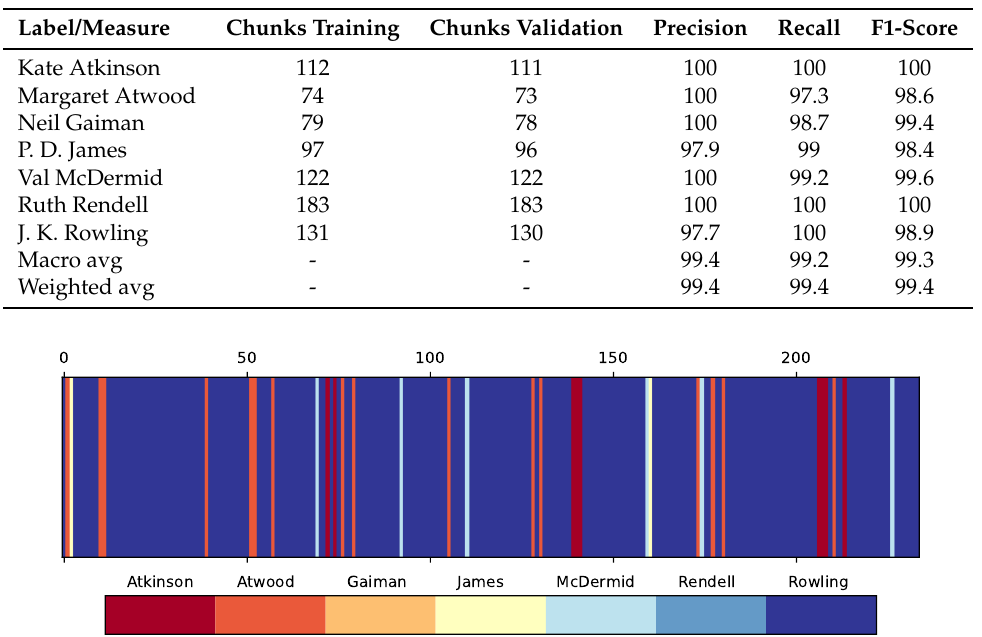
Table 4. Precision, recall and F1-score results for each class in turn for the validation set. The last two rows show the macro and weighted averages.